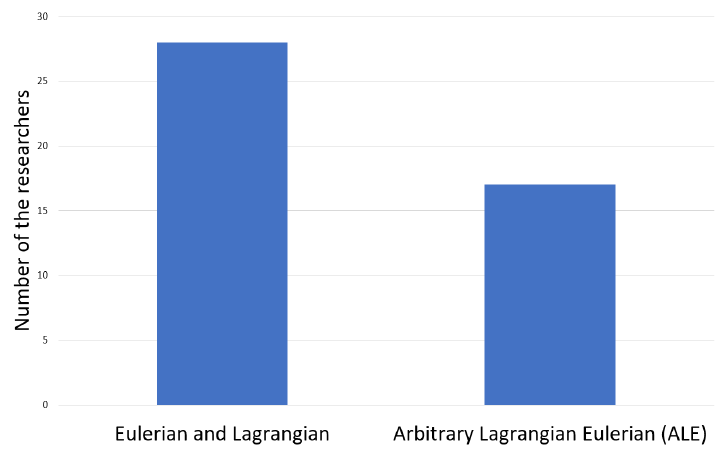
Figure 4. Number of researchers who employed different approaches.